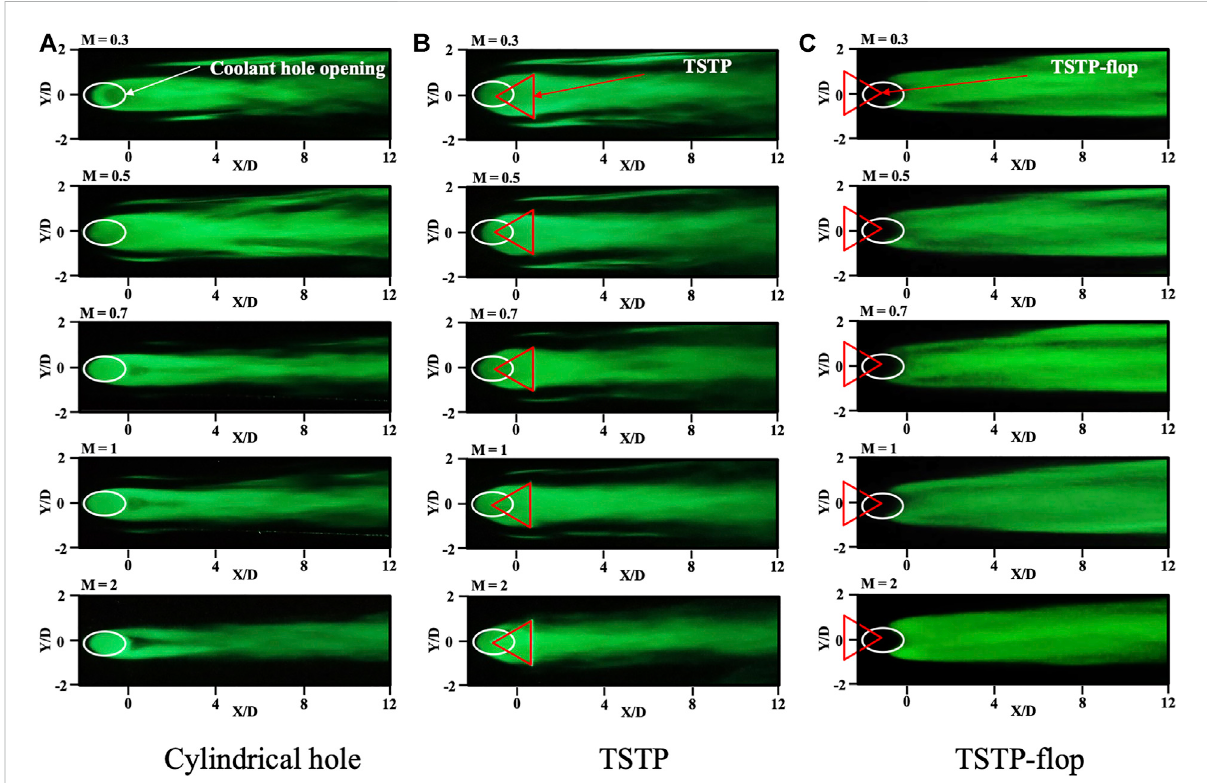
FIGURE 6 Flow fi eld visualization with varying blowing ratios for 0.3 to 2.0 in the center plane of the X-Y coordinate. Three columns represent cylindrical hole, TSTP, and TSTP- fl op,